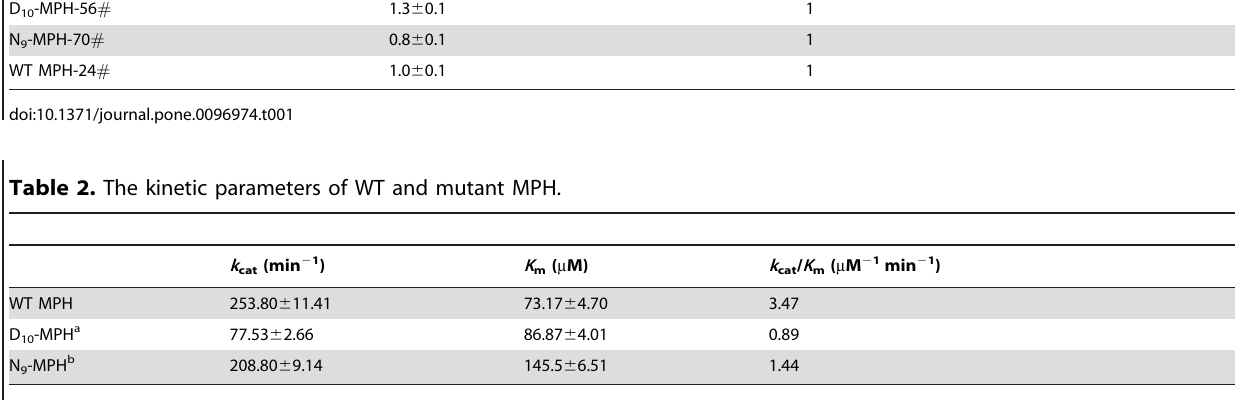
Figure S2, Enzyme activity in culture supernatants (a) and cells (b). Figure S3, The growth kinetics of the selected transformants. Figure S4, SDS/PAGE analysis of the purified WT MPH and mutants (N66-MPH, D10-MPH, N9-MPH). Figure S5, SDS- PAGE analysis of culture supernatants from 72 hours methanol induction. Figure S6, The interaction energy of the protein OPCH2, MPH and N9-MPH. (ZIP)